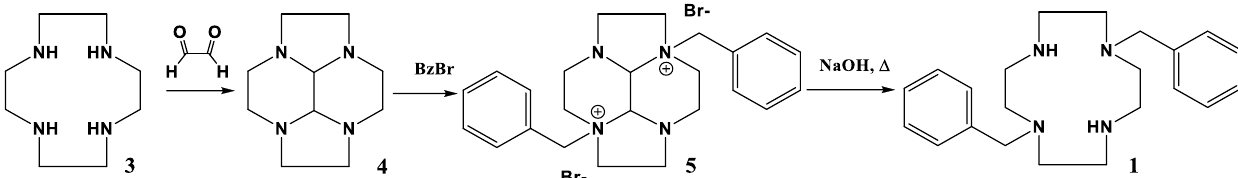
Figure 16. Synthetic scheme for 1,7-dibenzylcyclen ( 1 ) .